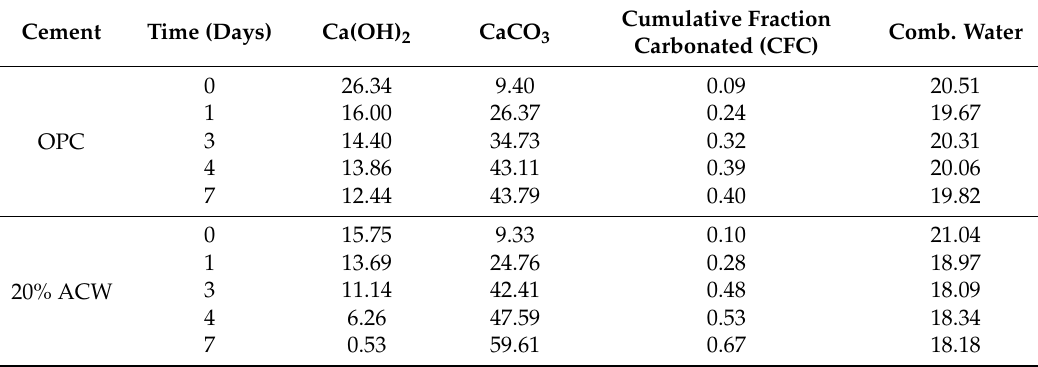
Table 6. Thermogravimetric findings on compounds in cement